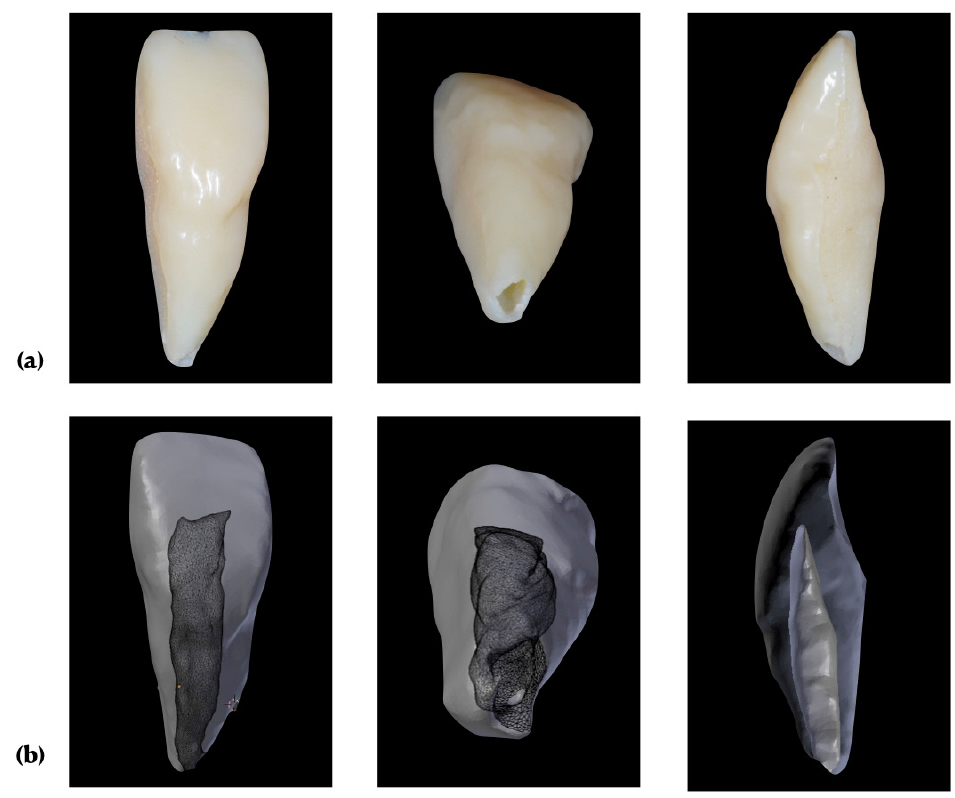
Figure 1. ( a ) 3D-printed central maxillary incisor, view from buccal, apical, and longitudinal section; ( b ) 3D rendering based on a micro-computed tomography imaging.